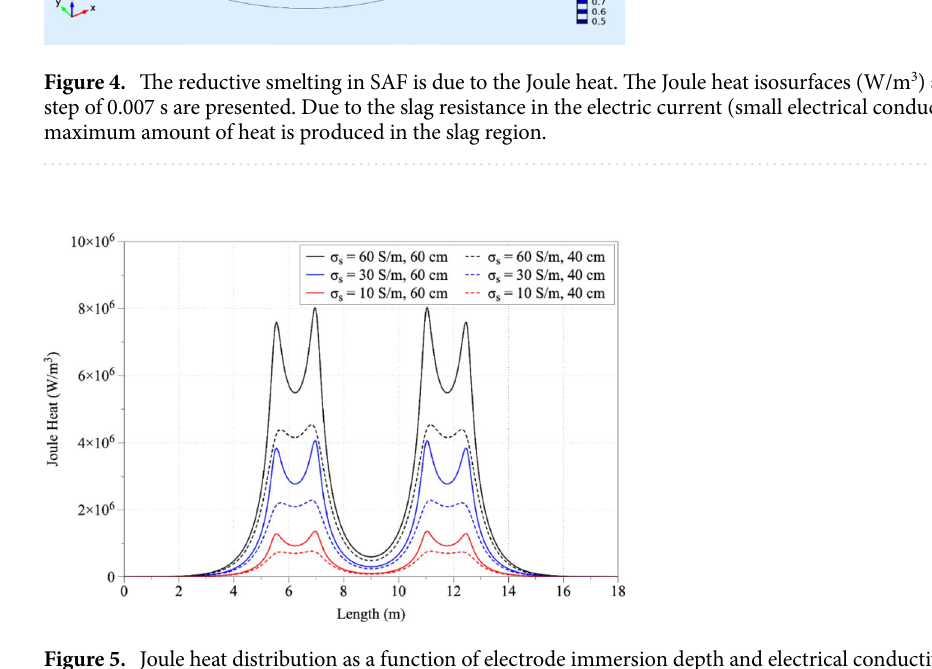
Figure 5. Joule heat distribution as a function of electrode immersion depth and electrical conductivity of the